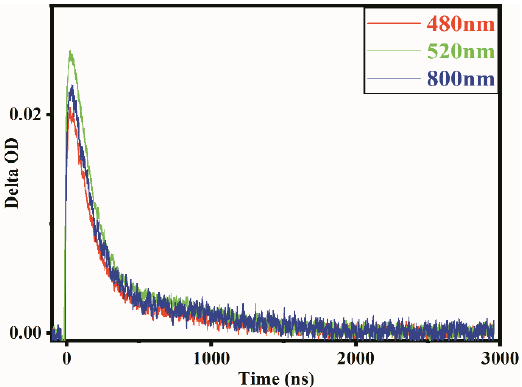
Figure 3. Temporal profiles of transient absorption spectrum on LaMn 0.6 Ni 0.4 O 3 observed at 480, 520 and 800 nm suspended in CH 3 OH.